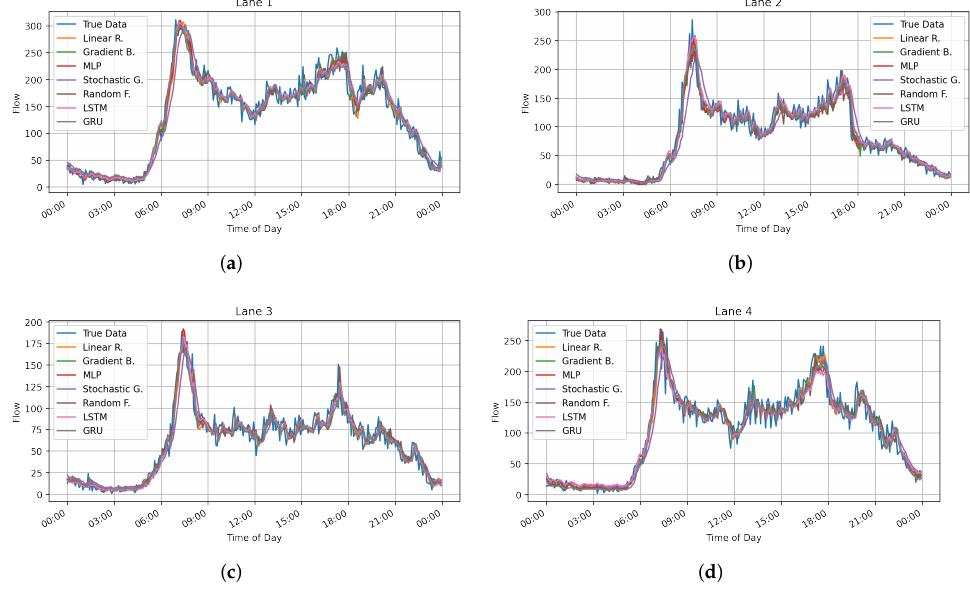
Figure 6. Comparison of traffic flow prediction models for one test day. ( a ) Traffic flow prediction of lane 1; ( b ) Traffic flow prediction lane 2; ( c ) Traffic flow prediction lane 3; ( d ) Traffic flow prediction lane 4.